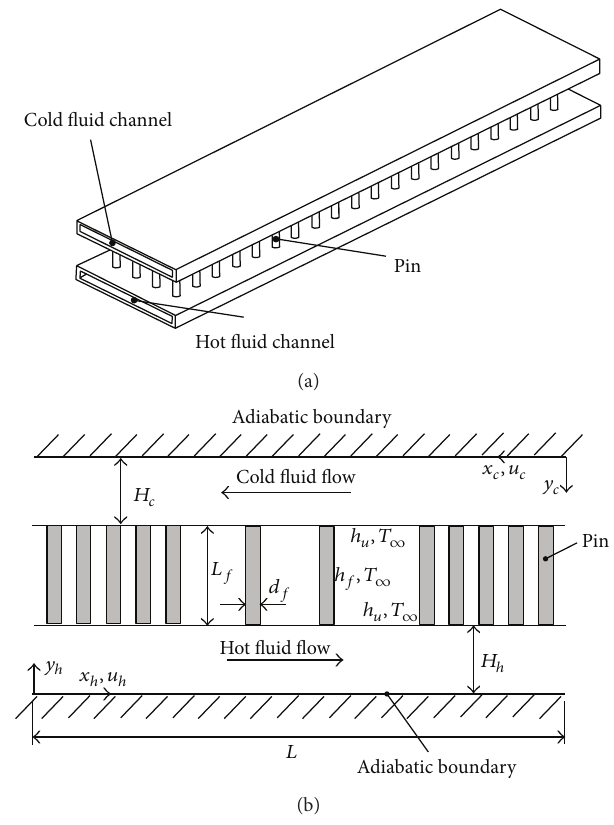
Figure 1: (a) 3D view of the counterflow plate heat exchanger with intermediate auxiliary channel and (b) schematic profile of the device and the coordinates